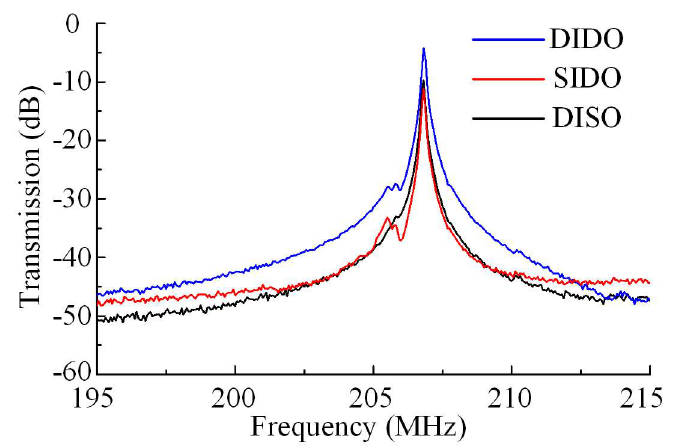
Figure 12. Measured electromechanical frequency response to compare the effect of using the DIDO setup against the SIDO and DISO setups. The feedthrough suppression measured in the SIDO setup is slightly different from that in DISO setup. Both of them suppress the feedthrough better than the DIDO setup, but the insertion loss measured in the DIDO setup is the best.